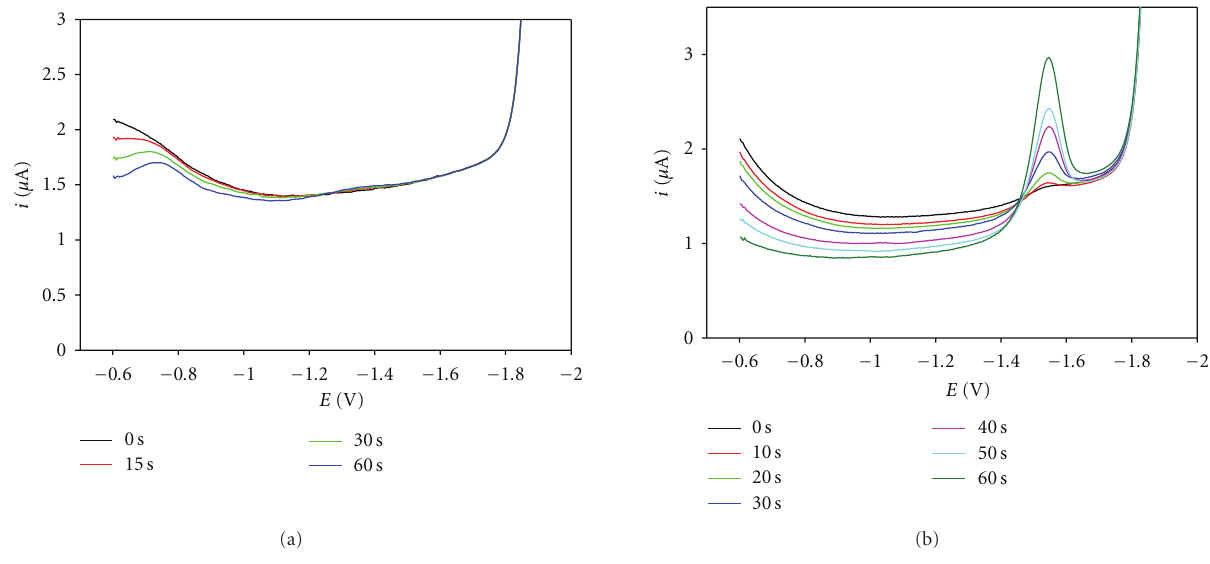
Figure 1: i ac - E curves for (a) humic acid, 25.85 mg/L, and (b) Triton-X-100, 0.143 mg/L, recorded for increasing deposition times in 0.55 M NaCl solution. Deposition potential was − 0.6 V, amplitude 10mV, and frequency 75 Hz.